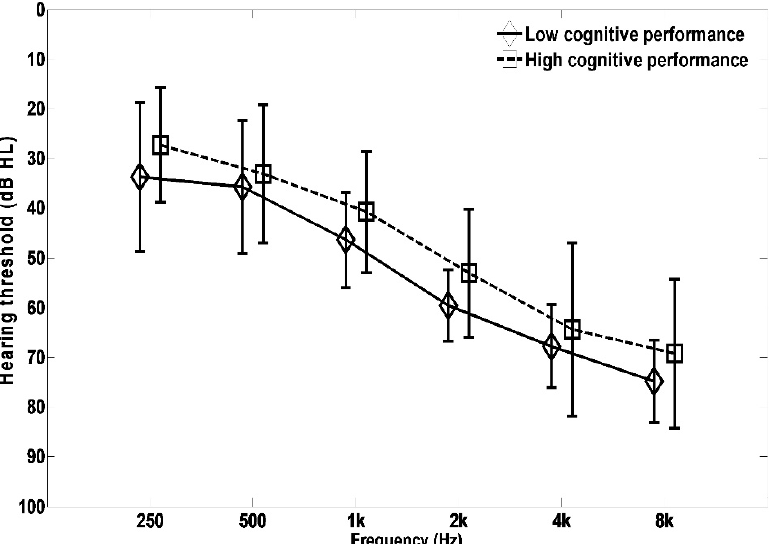
Figure 6. Mean audiograms for the low and the high cognitive performance groups. In each group, hearing thresholds for the left and the right ears were combined.